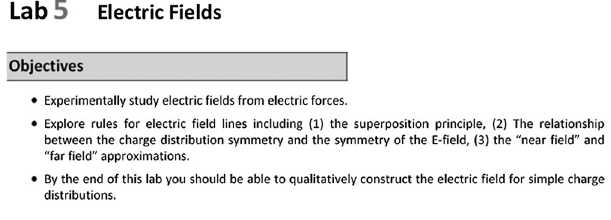
FIG. 5. The list of learning objectives from a lab about electric field and force at the same institution as that used in Fig.